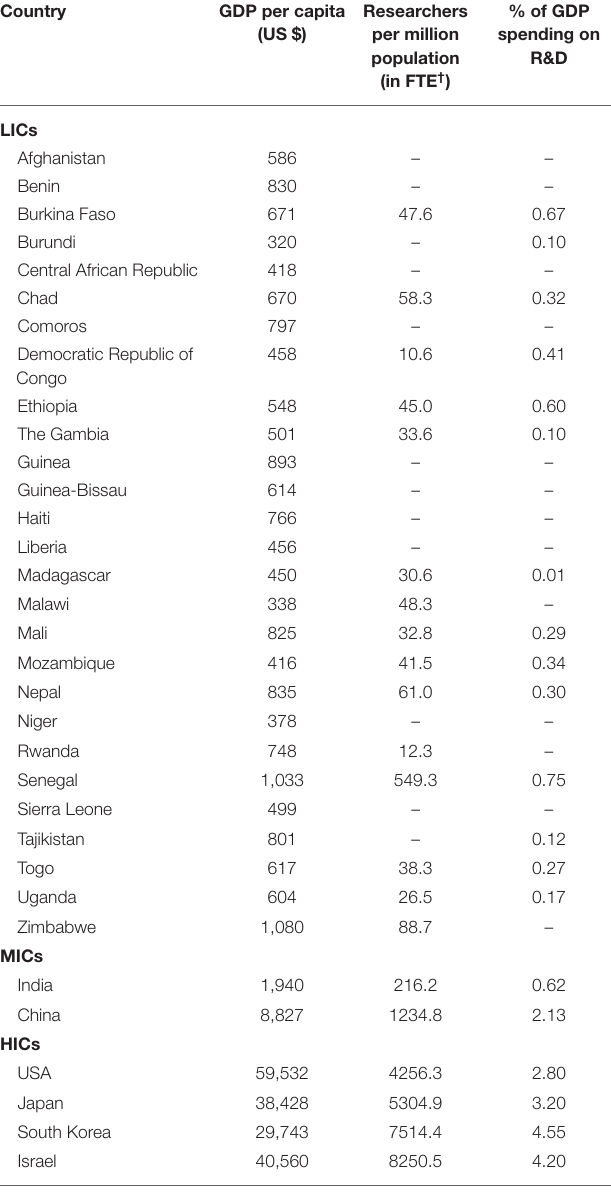
TABLE 1 | List of LICs, MICs, and HICs by GDP per capita and R&D spending. Country GDP per capita (US